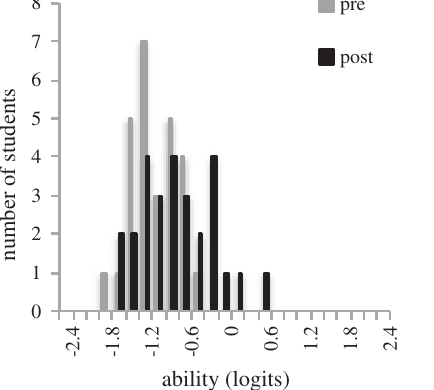
FIG. 42. The pre- and postability histogram for class 28.